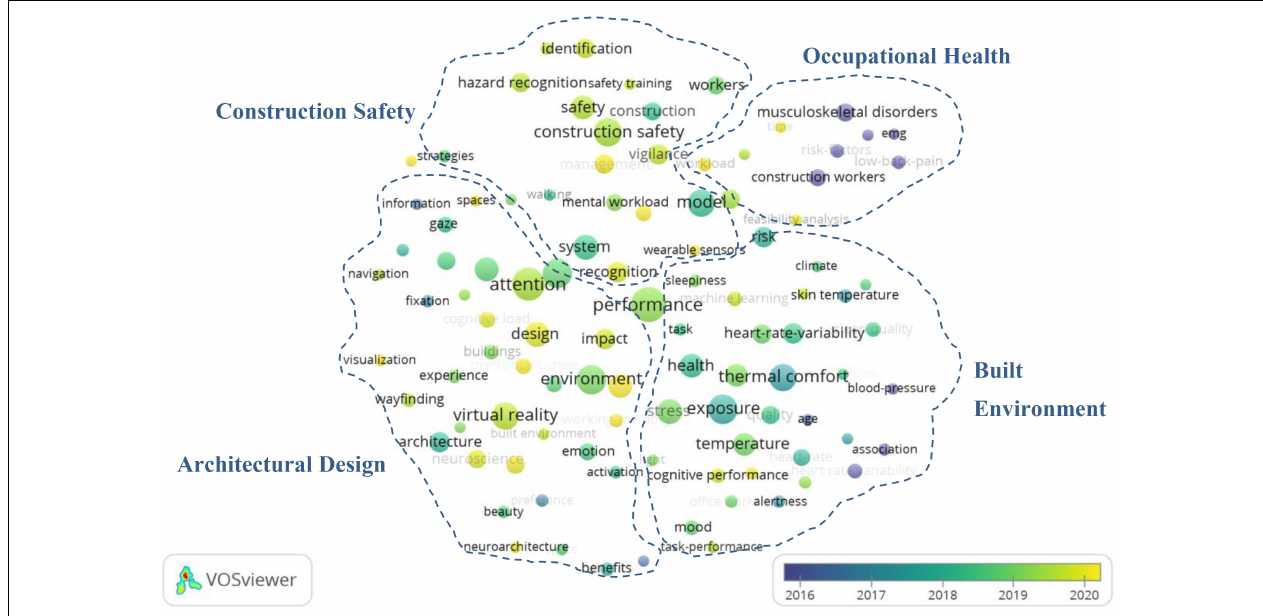
FIGURE 5 | Keywords co-occurrence network of neuroscience tools in building